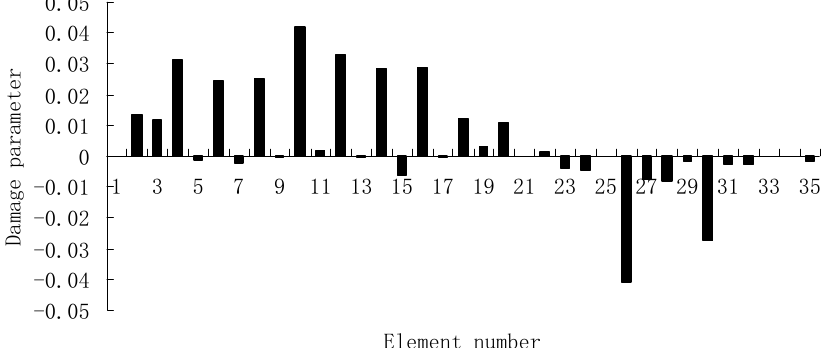
Figure 3. Damage evaluation result by the traditional SVT method for case 1 (element 10 had 20% stiffness reduction).